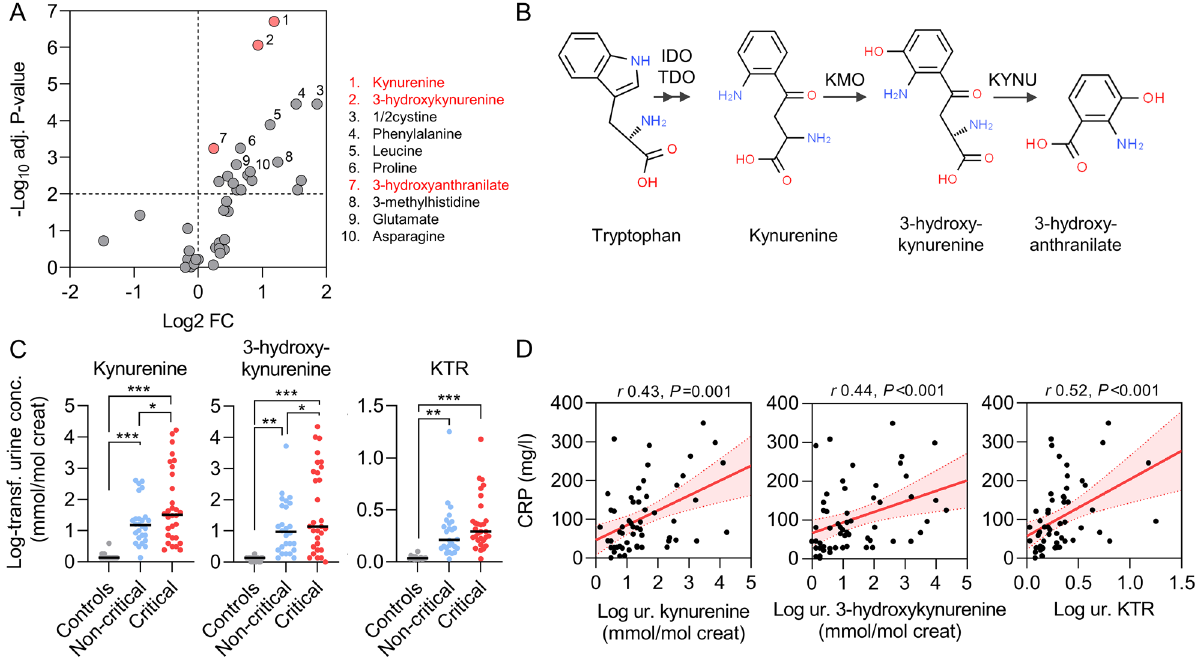
Figure 2. Dysregulation of the tryptophan-kynurenine pathway in the urine of patients with COVID-19. ( A ) Volcano plot comparing log-transformed levels of urine metabolites in COVID-19 patients versus healthy controls. Significantly altered (increased) tryptophan metabolites are highlighted in red and the ten top dysregulated metabolites are identified with numbers and text. Two-sided Mann–Whitney U test followed by Benjamini and Hochberg multiple comparison test with false discovery rate (FDR) < 0.01. ( B ) Metabolites of the kynurenine pathway. Chemical structures were obtained from ChemSpider (www. chems pider. com), 2021. TDO, tryptophan 2,3-dioxygenase; IDO, indole 2,3-dioxygenase; KMO, kynurenine 3-monooxygenase; KYNU, kynureninase. ( C ) Comparison of log-transformed urinary levels of kynurenines and kynurenine to tryptophan ratio among controls (grey), non-critical (blue) and critical (red) COVID-19 patients. Data are individual values and medians. Comparisons using a one-way ANOVA followed by Holm-Sidak correction for multiple comparison. ( D) Systemic inflammation, assessed by the plasma level of C-reactive protein (CRP) at the time of sampling, correlates with urinary (ur.) concentration of kynurenine, 3-hydroxykynurenine and the kynurenine to tryptophan ratio (KTR) in COVID-19. Data are individual values (black dots), and linear regressions with 95% confidence intervals (red